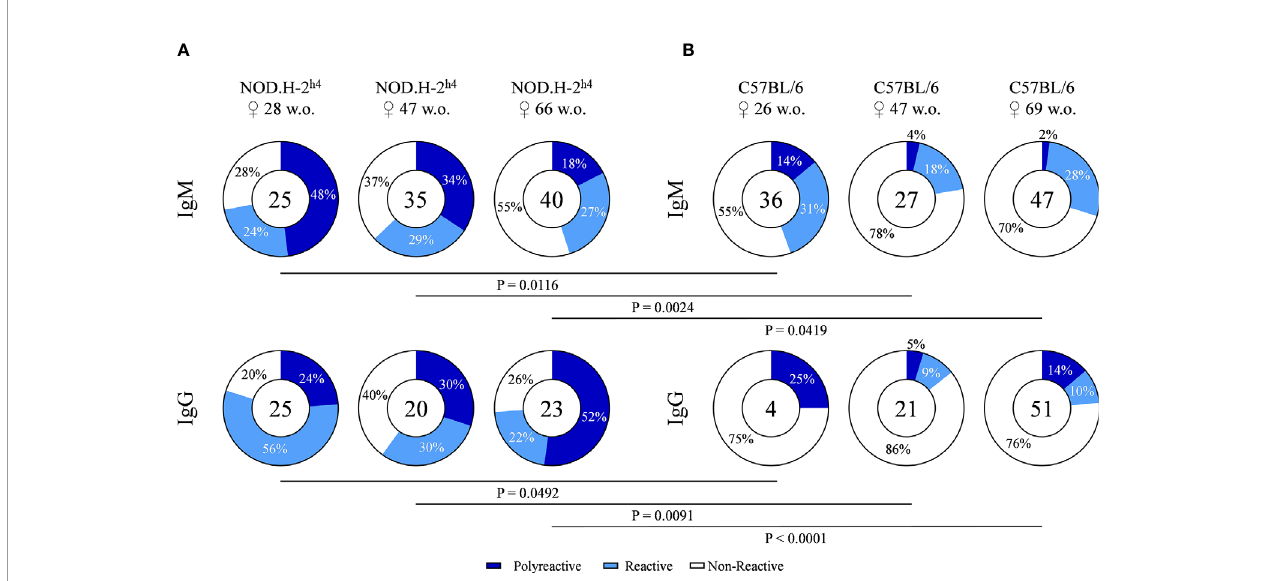
FIGURE 3 | Frequency of polyreactive antibodies derived from NOD.H-2 h4 and C57BL/6J mice. Antibody reactivity against dsDNA, H1, Ro52, LPS, Insulin and OVA was evaluated by ELISA. Pie charts showing the proportion of polyreactive (reactivity ≥ 3 antigens) (dark blue), reactive (one or two antigen) (light blue) and non- reactive (white) antibodies determined by ELISA. Data for each age NOD.H-2 h4 : 28, 47 and 66 w.o. (A) ; C57BL/6J: 26, 47 and 69 w.o. (B) ] and both IgM and IgG isotypes are shown. The number of tested antibodies is indicated in the pie chart center. Data are pooled from independent experiments for each mouse age. P-values were calculated by c 2 test.